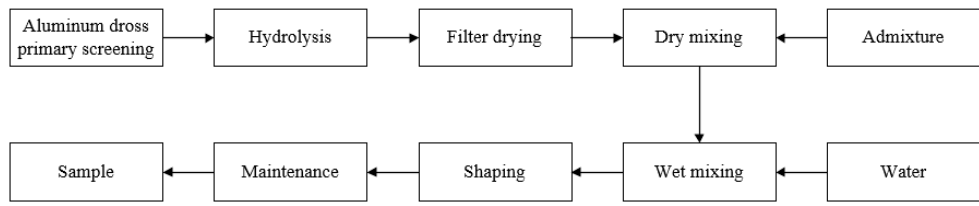
Figure 1. Sample preparation flow chart.